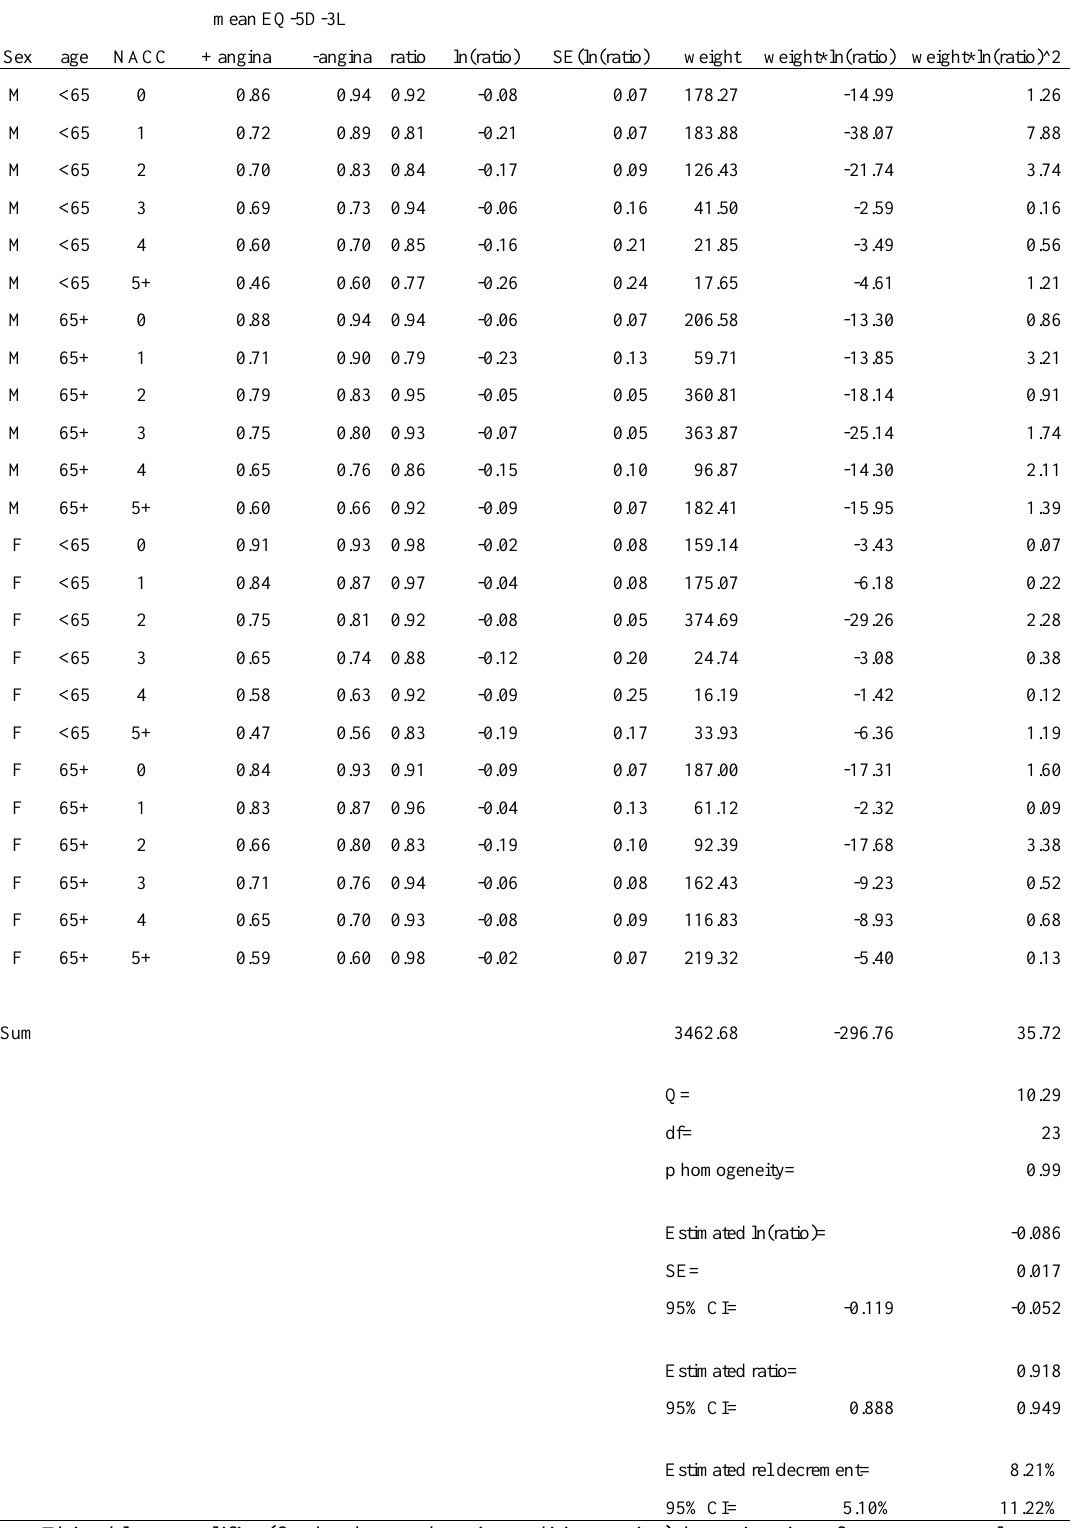
Table A1: Calculation of percentage-scale decrements using stratified